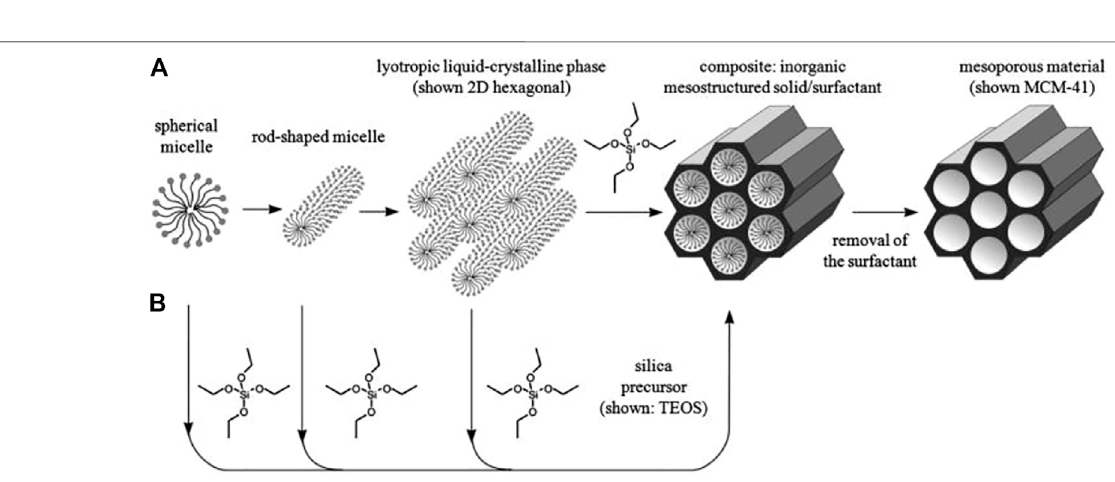
Frontiers in Chemistry |